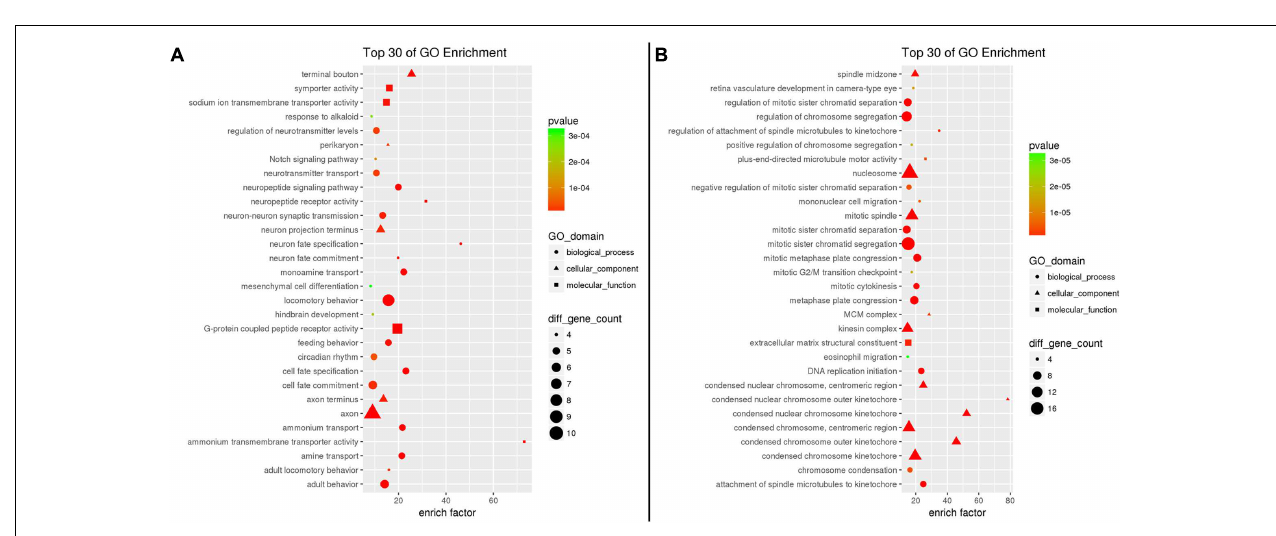
FIGURE 3 | Results of Gene Ontology enrichment analysis for down-DEGs reversed by THSWD (A) and down-DEGs (B) resulting from MCAO.